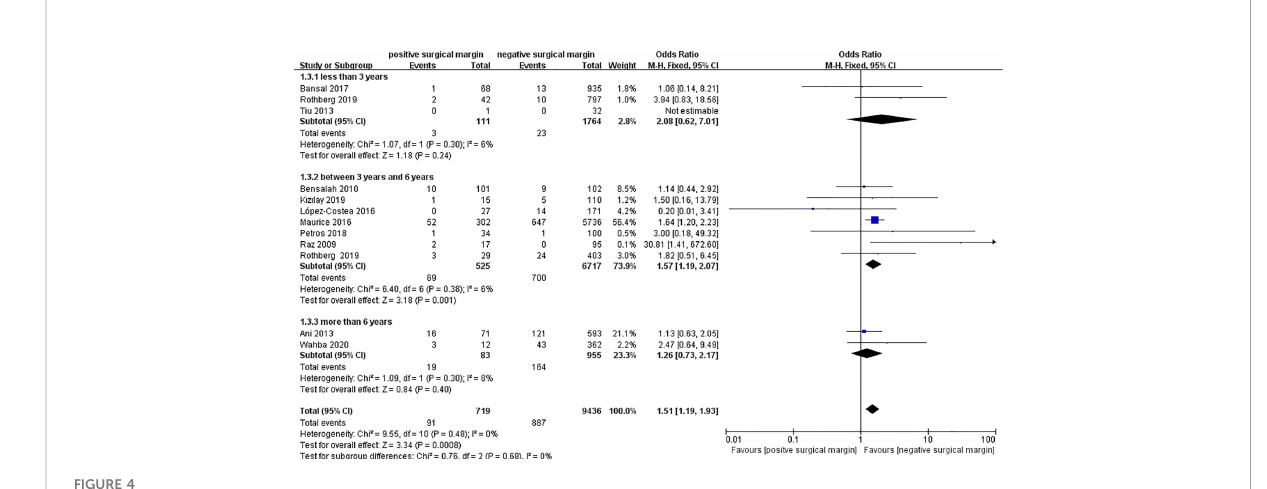
FIGURE 4 Comparison of all-cause death between PSM and NSM